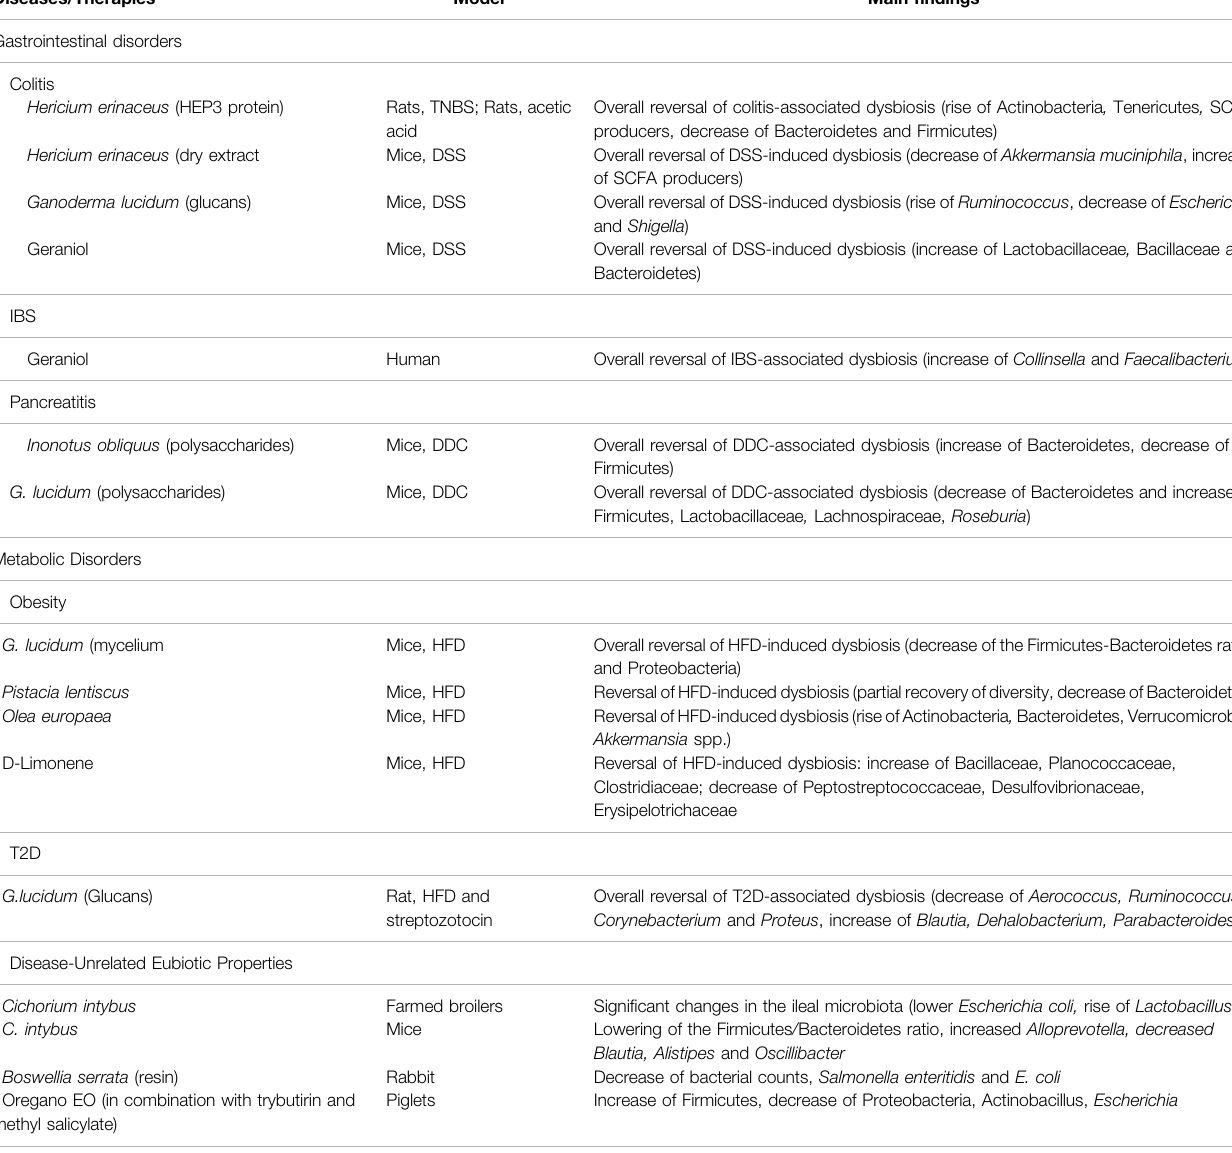
TABLE 2 | Fungus, plants and EO molecules as GM modulators in clinical studies and in preclinical model of non-communicable diseases.